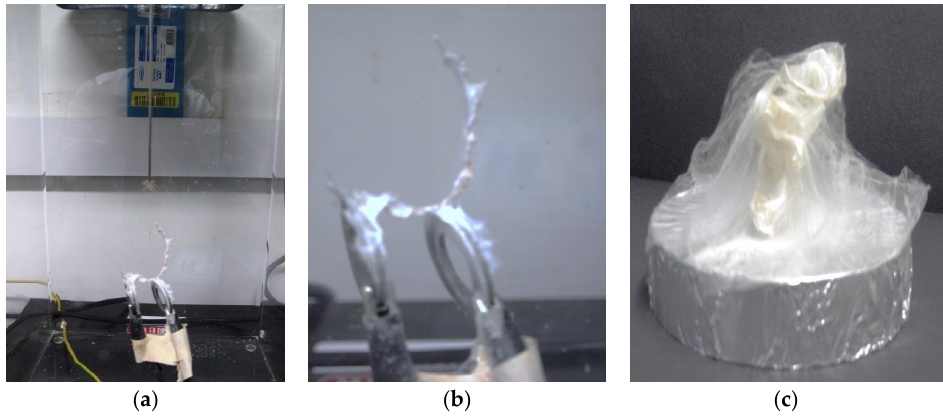
Figure 2. Fabrication of three dimensional (3D) electrospun scaffolds using regenerated natural Bombyx mori silk; ( a ) modification of electrospinning collector; ( b ) electrospun scaffold; ( c ) 3D natural silk electrospun using oval shape collector.